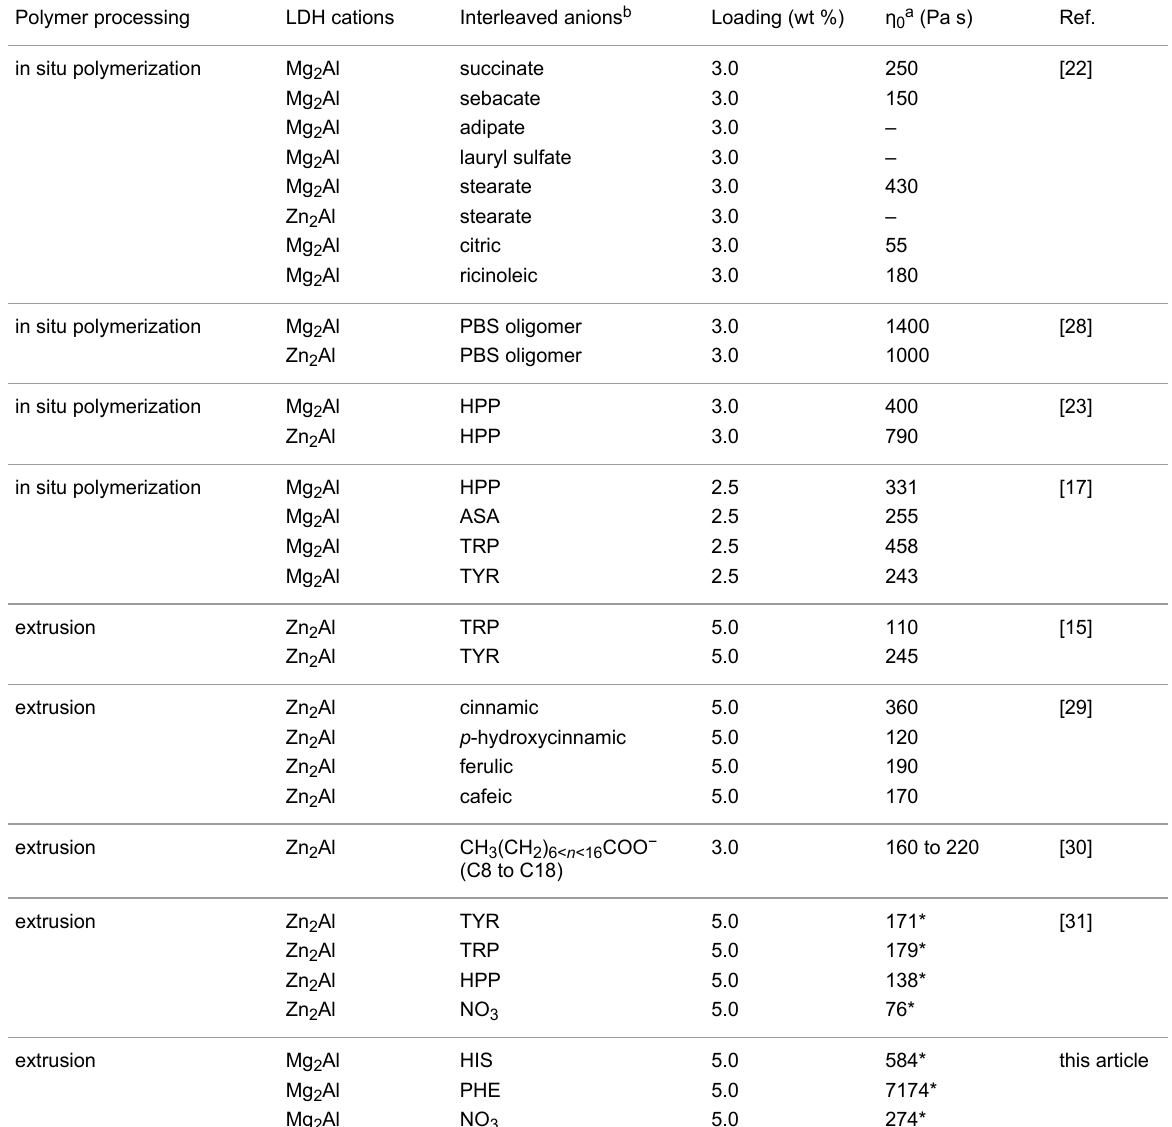
Table 3: Polymer processing and Newtonian zero-shear viscosity η 0 for PBS–LDH nanocomposites. Polymer